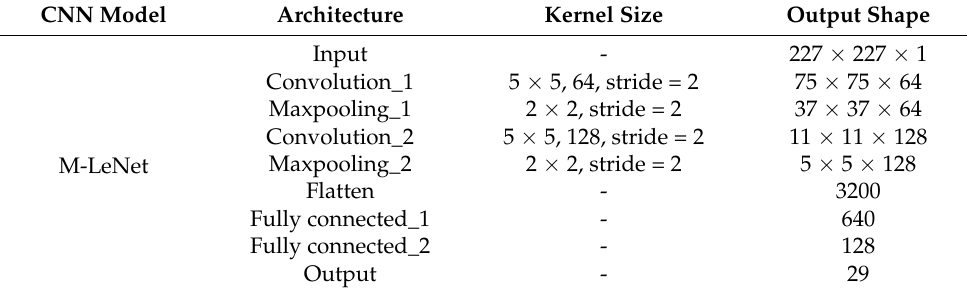
Table 1. The architecture of M-LeNet5.